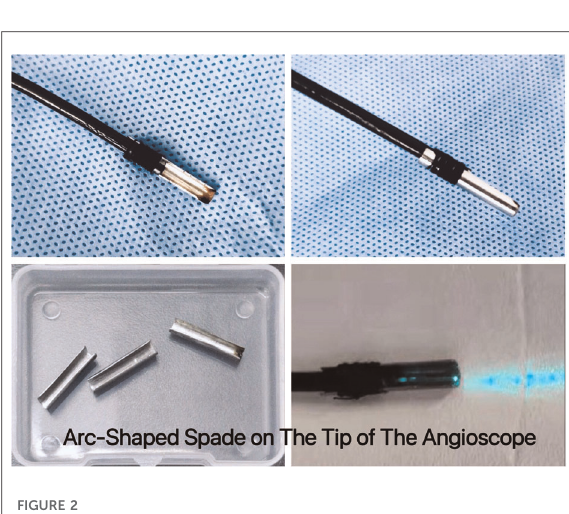
FIGURE 2 Arc-shaped spade was fi xed on the tip of the angioscope. The spade was made by stainless steel with a radius angle of 180 – 220° (0.1 mm thickness). The arc-shaped spade had two kinds of functions, one was for dissecting the plaque from the wall of internal carotid artery by rotating and pushing the scope handle, the other was to be used as a physical barrier to protect the artery wall from being injured by the